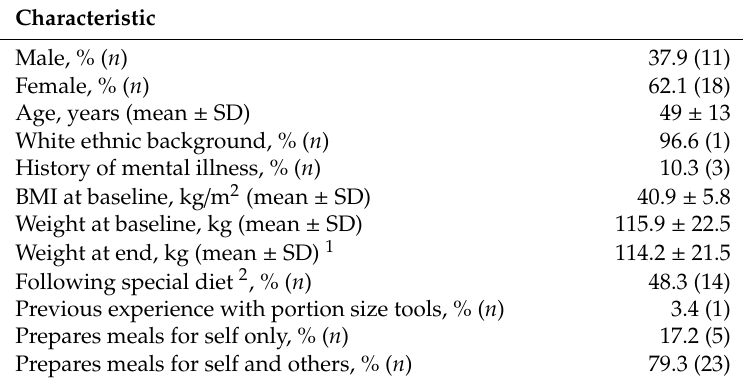
Table 1. Characteristics of participants ( n = 29) in a qualitative portion-control tool